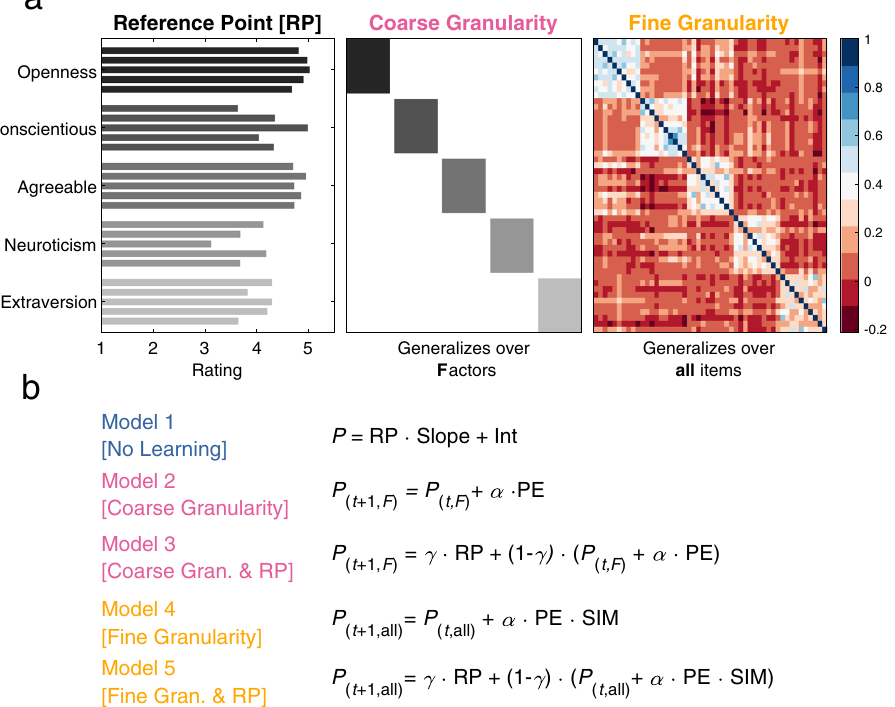
different colours. First, No Learning (blue), consists of a single regression model, Model 1 [No Learning] that functions as a baseline model. Second, Coarse Granu- larity (pink), updates based on the (Big-Five) factor to which the current adjective belongs. Model 2 [Coarse Granularity] uses the standard Rescorla – Wagner (RW) function to update the factor estimates and Model 3 [Coarse Granularity & Popu- lation RP]combines Model 2 with information from the RP.Third, Fine Granularity (orange), consists of two models that update all adjectives based on their corre- lationwiththecurrenttrait.Model4[Fine Granularity]updatesallitemsaccording to the Fine Granularity and Model 5 [Fine Granularity & Population RP] combines model 4 with information from the RP (see Supplementary Fig. 1 for details on the models). P prediction, Int intercept, RP reference point, α learning rate, PE pre- dictionerror, γ weightingparameter,F(generalizesoverFactor)coarsegranularity, All (generalizes over All items) fi ne granularity, SIM similarity